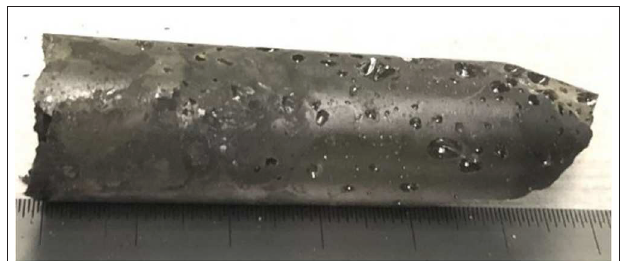
FIGURE 1 | 6 LiInSe 2 ingot (G77) after crystal growth.